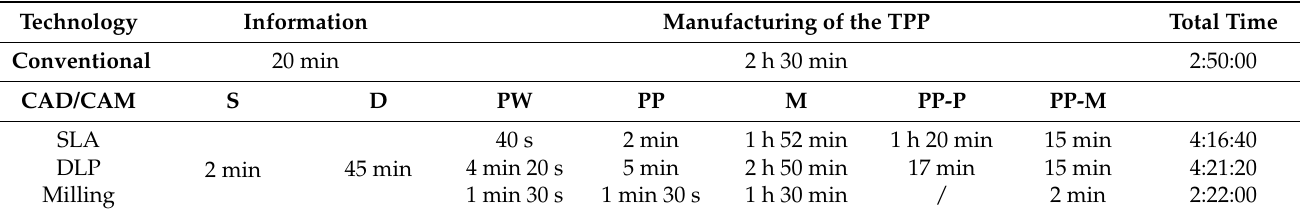
Table 1. Approximation of the timing for creation and manufacturing of a single TPP (without wire) by the different techniques. Time for the different steps of the CAD/CAM technologies was divided also measured: scanning of the patient (S), designing of the TPP (D), preparing the manufacturing workfile (PW), preparing the printer/milling machine (PP), manufacturing (M), post-processing printer (PP-P), manual post-processing (PP-M). Technology